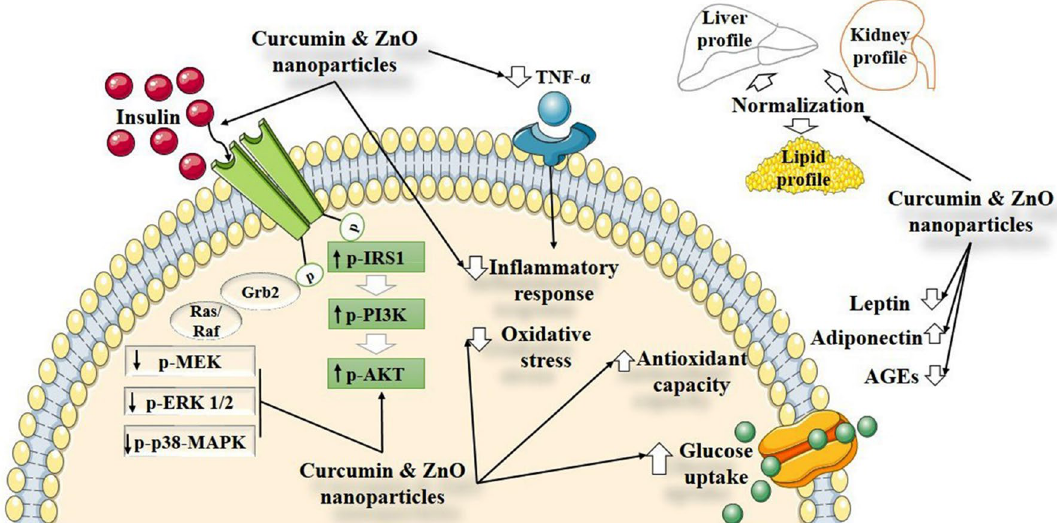
Figure 10. Schematic illustration for the effects of ZnONPs and CurNPs on pathways-related T2DM. HFD/ STZ induced hyperglycemia, dyslipidemia, cellular stress, insulin resistance, causing the inhibition of PI3K/AKT and activation of p38-MAPK. ZnONPs and CurNPs administration displayed protective mechanisms at cellular and molecular levels. Both nanoparticles could protect tissues from diabetic complications via upregulation of PI3K/AKT pathway, down-regulation of p38-MAPK pathways, and attenuation of oxidative and inflammatory pathways. ( ↑ ): Up-regulated targets; ( ↓ ) Down-regulated